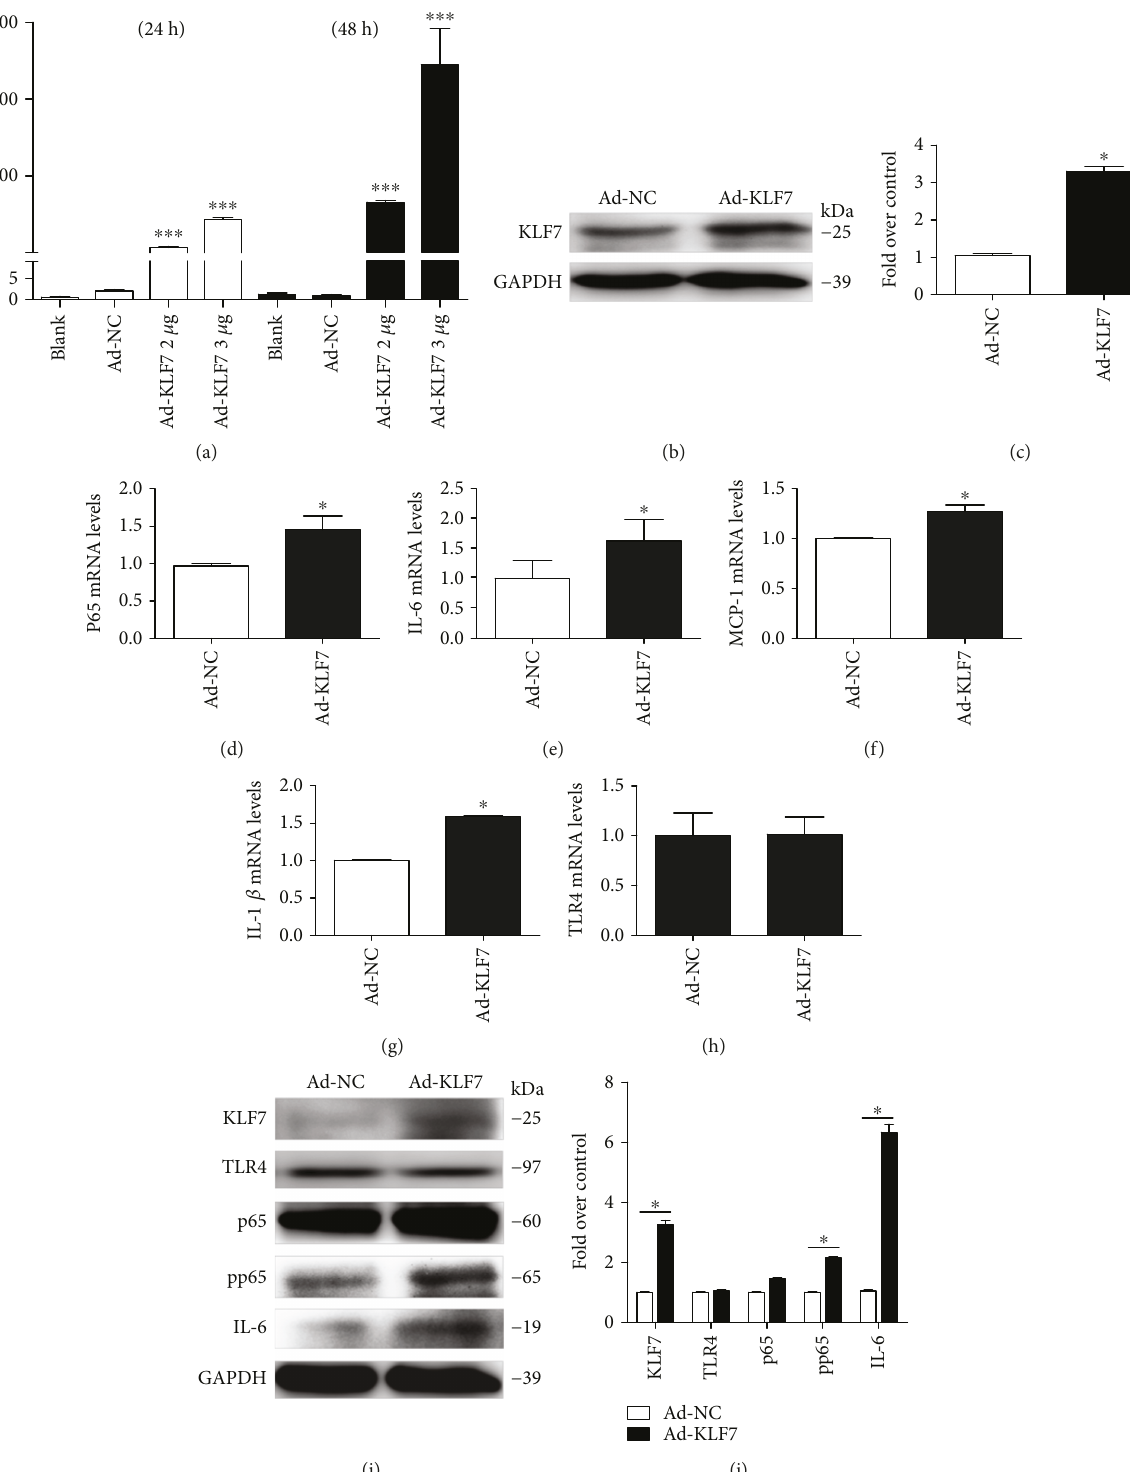
Figure 3: Detection of KLF7 mRNA expression at 24 h and 48h after transfection of mature adipocytes with 3 μ g/mL KLF7 overexpression plasmid (a). The expression of KLF7 protein was further detected after 48h of transfection (b, c). The mRNA and protein expression of in fl ammatory factors in adipocytes after 48 h transfection with KLF7 overexpression plasmids (d – i). Grayscale scanning of (b) and (i) proteins (c, j) (Ad-KLF7: transfected KLF7 overexpression plasmid; Ad-NC: transfected KLF7 negative control overexpression plasmid). The data for each group is derived from three replicates of experimental data. One-way ANOVA (a), T test (c, d, f – h, j), Wilcoxon rank sum test (e), Ad-NC: Ad-KLF7, ∗ P < 0 05 , ∗∗∗ P < 0 001 ; the di ff erence was statistically signi fi